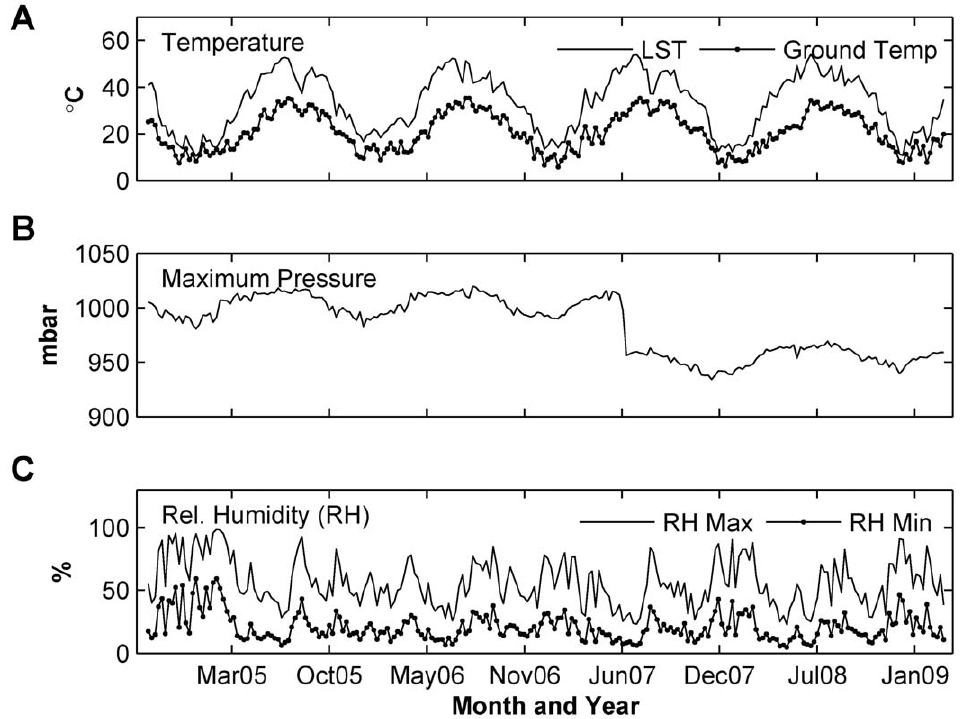
Figure 5. Maricopa environmental variables. (A) LST weekly average and Mean Temperature from ground station, (B) weekly average maximum pressure and (C) weekly average of minimum and maximum relative humidity.